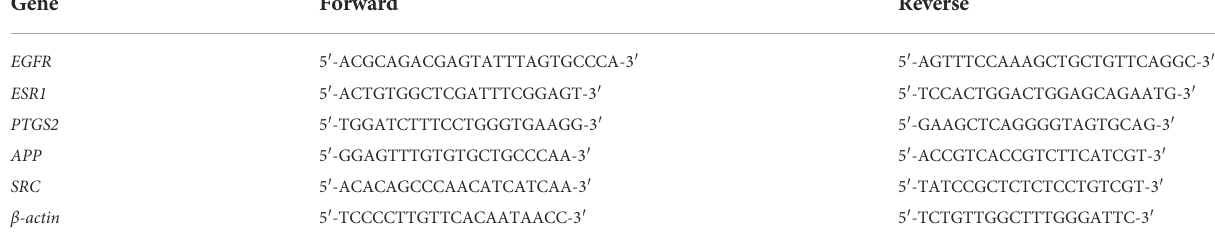
TABLE 1 Primer sequence used for PCR